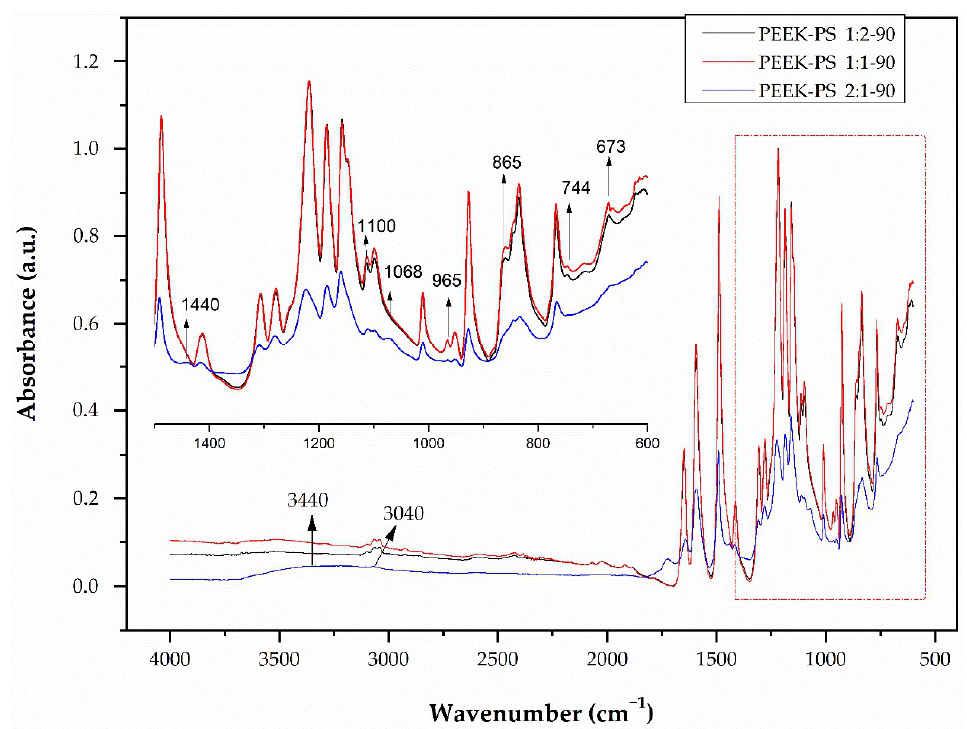
Figure 5. PEEK-PS FTIR spectra at concentrations of 1:2, 1:1, and 2:1 with 90 s of immersion in the piranha solution.